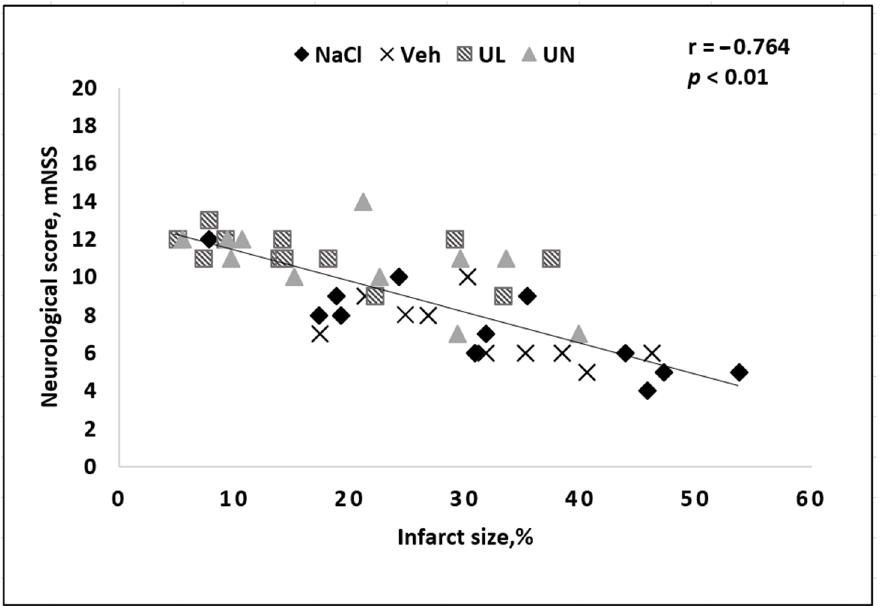
Figure 7. Correlation between the size of the brain infarct size and the severity of neurological deficit in rats after occlusion of the middle cerebral artery. Groups: NaCl–MCAO+NaCL; Veh–MCAO+Vehicle; UL–MCAO+Ubiquinol; UN–MCAO+Ubiquinone.